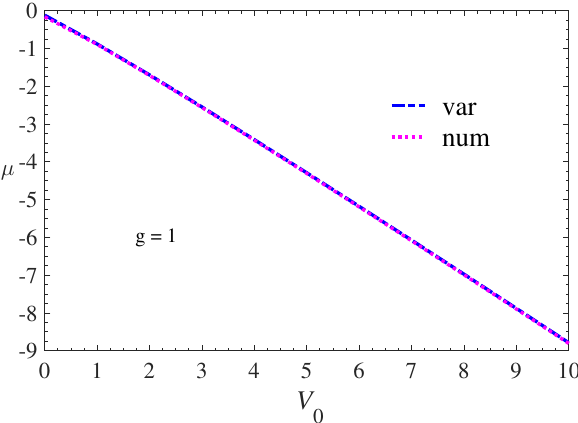
Figure 3. Variational and numerical results of chemical potential, µ , versus amplitude, V 0 , of PT potential − V 0 sech 2 ( x ) . We consider in this simulation g = 1. The variational results are represented by the dashed curve (blue) while the numerical results are represented by the dotted curve (magenta). Similar behavior was observed in studies of stable gap solitons in SFGs trapped by optical lattices and optical